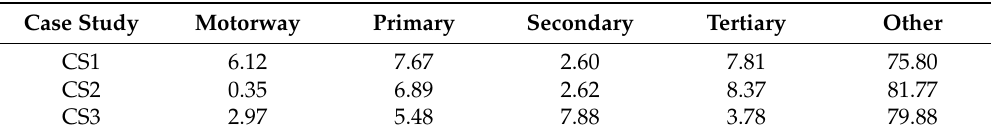
Table 4. Fraction of street types in a street network.